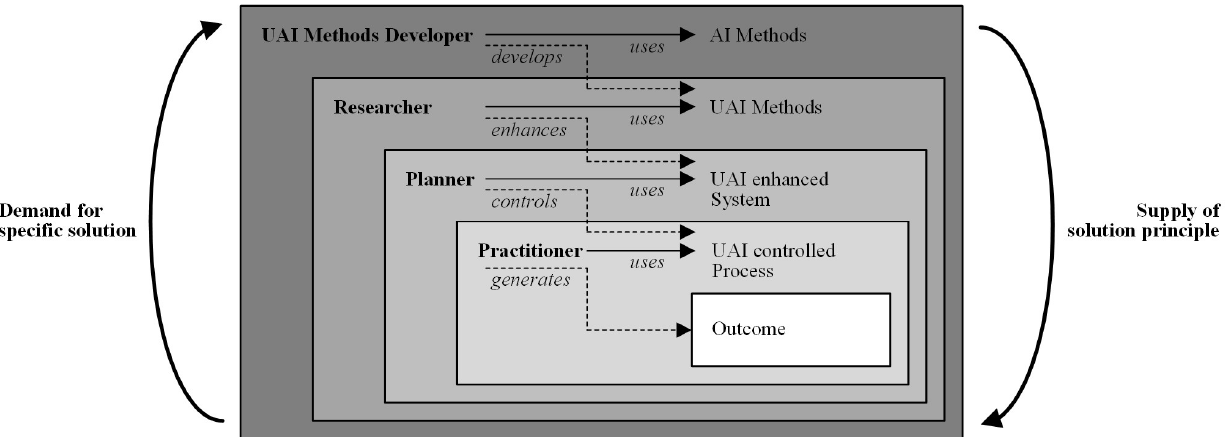
Figure 2. Relation of relevant user roles and respective AI application goals.